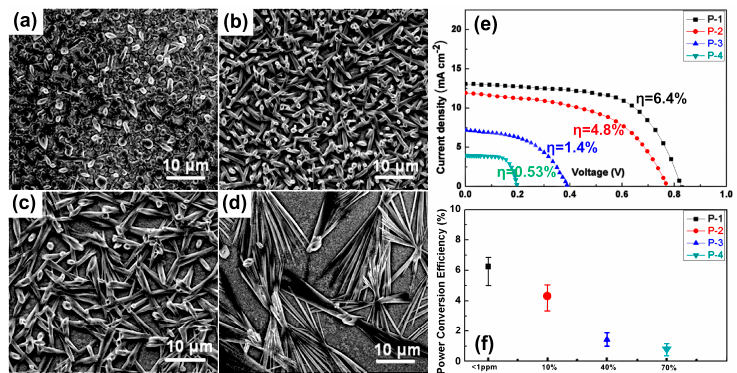
Figure 4. SEM images of perovskite MAPbI 3 films deposited on mp-TiO 2 layer under different ambient humidities, i.e., ( a ) <1 ppm (P-1); ( b ) 10% (P-2); ( c ) 40% (P-3) and ( d ) 70% (P-4); ( e ) J–V curves of the perovskite solar cells prepared under different ambient humidities of MAPbI 3 ; ( f ) Dependence of the PCEs on RH. Each data point represents the mean from a set of 10 devices [60]. Copyright © 2015, American Chemical Society.